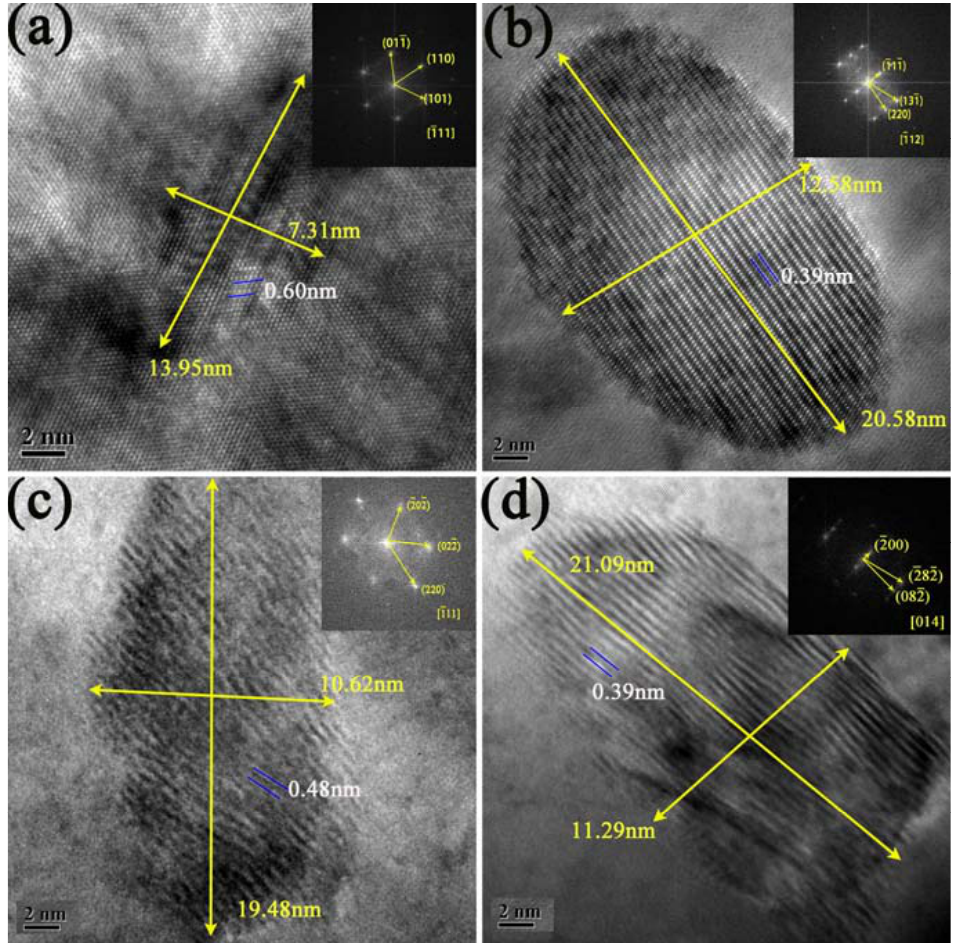
Figure 12. HRTEM images of deposited metals. ( a ) Cu 0.62, ( b ) Cu 1.38, ( c ) Cu 1.79, ( d ) Cu 2.32.